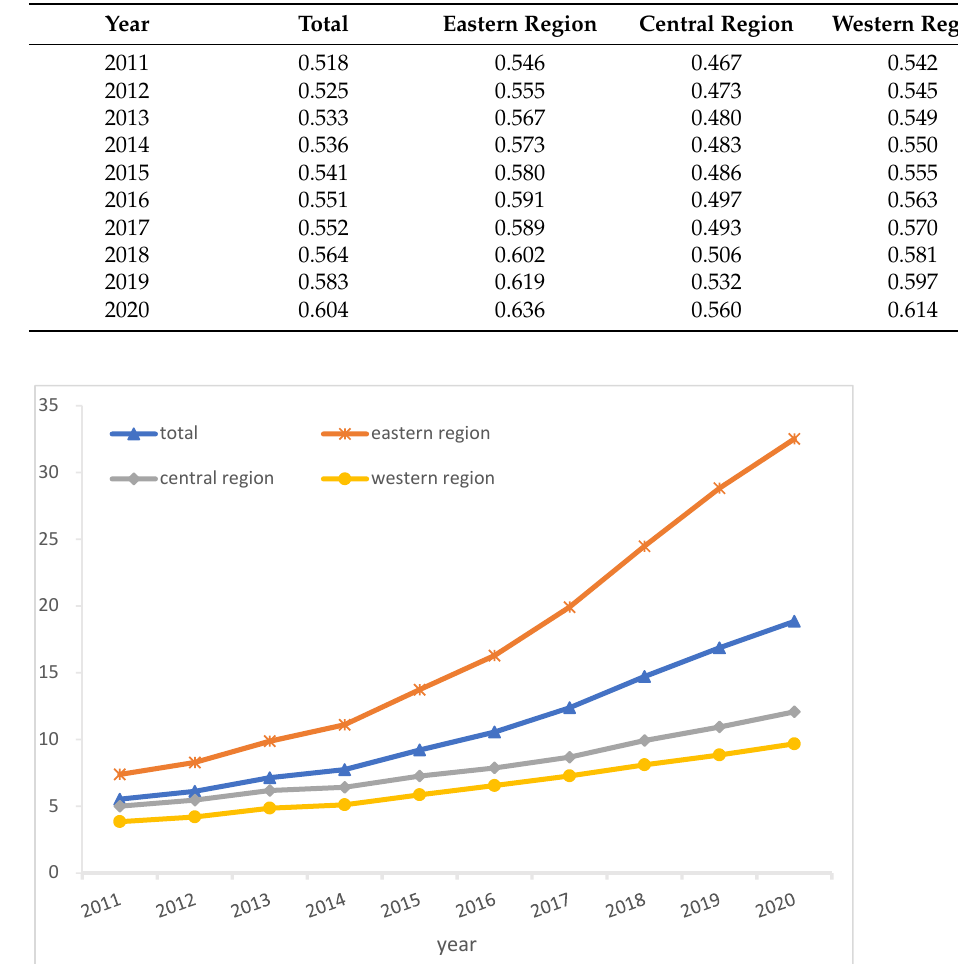
Figure 5. Trend of regional digital economy development level.